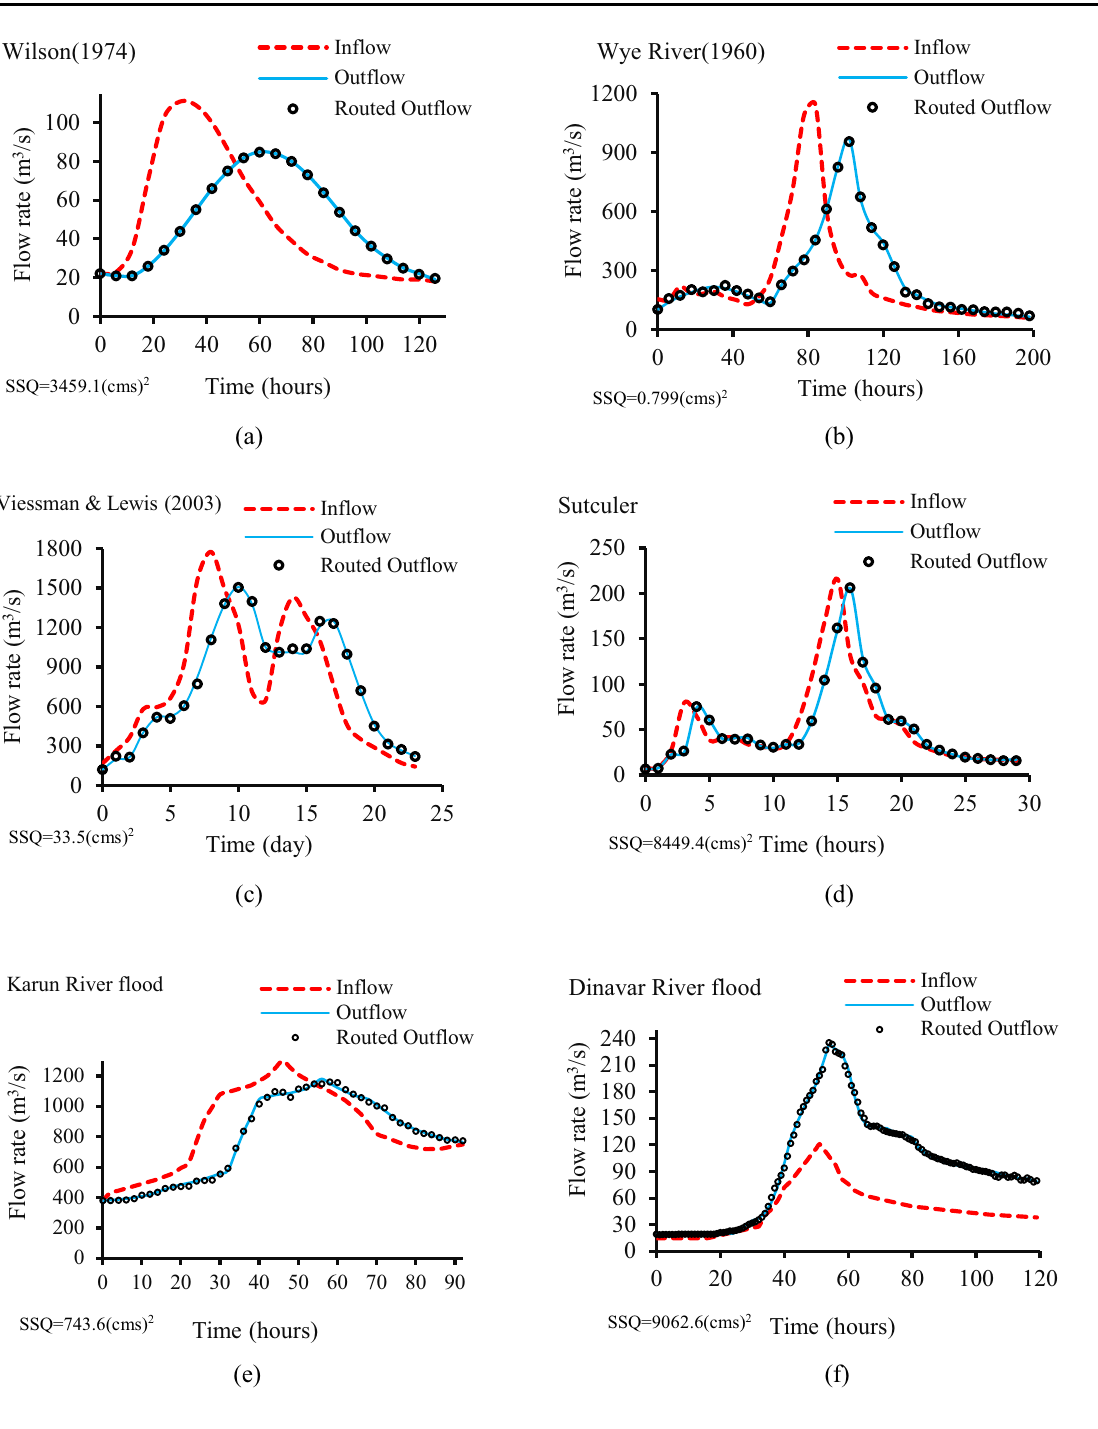
Fig. 2 Inflow, outflow and routed hydrographs for examples a Wilson flood b Wye River flood c Viessman and Lewis data d Sutculer flood